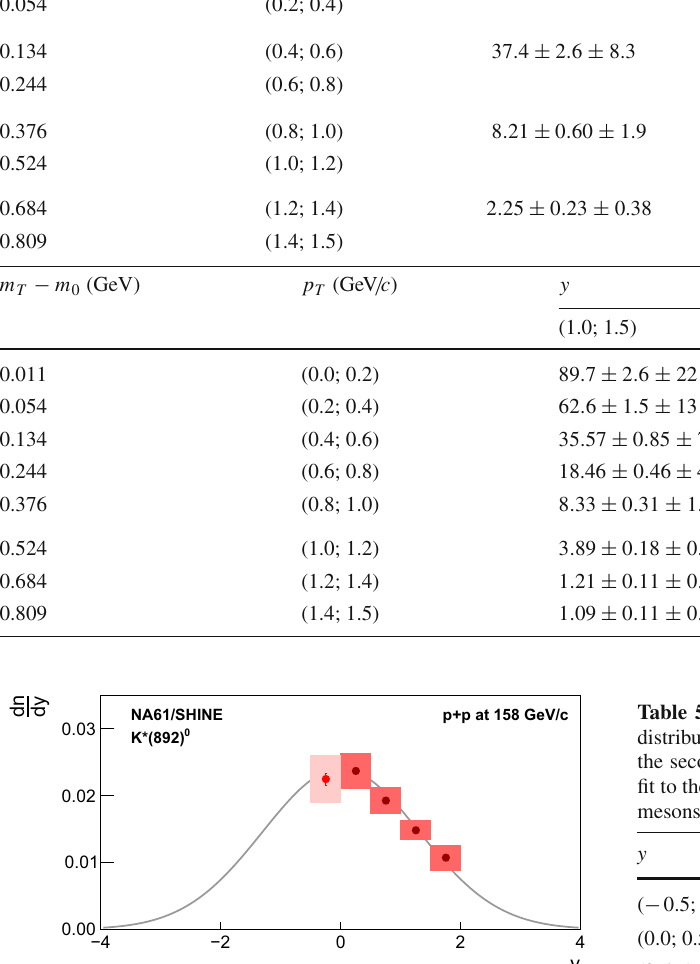
Table 4 Numerical values of double-differential yields 1 specify the bin centers. The first uncertainty is statistical, while the second one is systematic m T − m 0 (GeV)